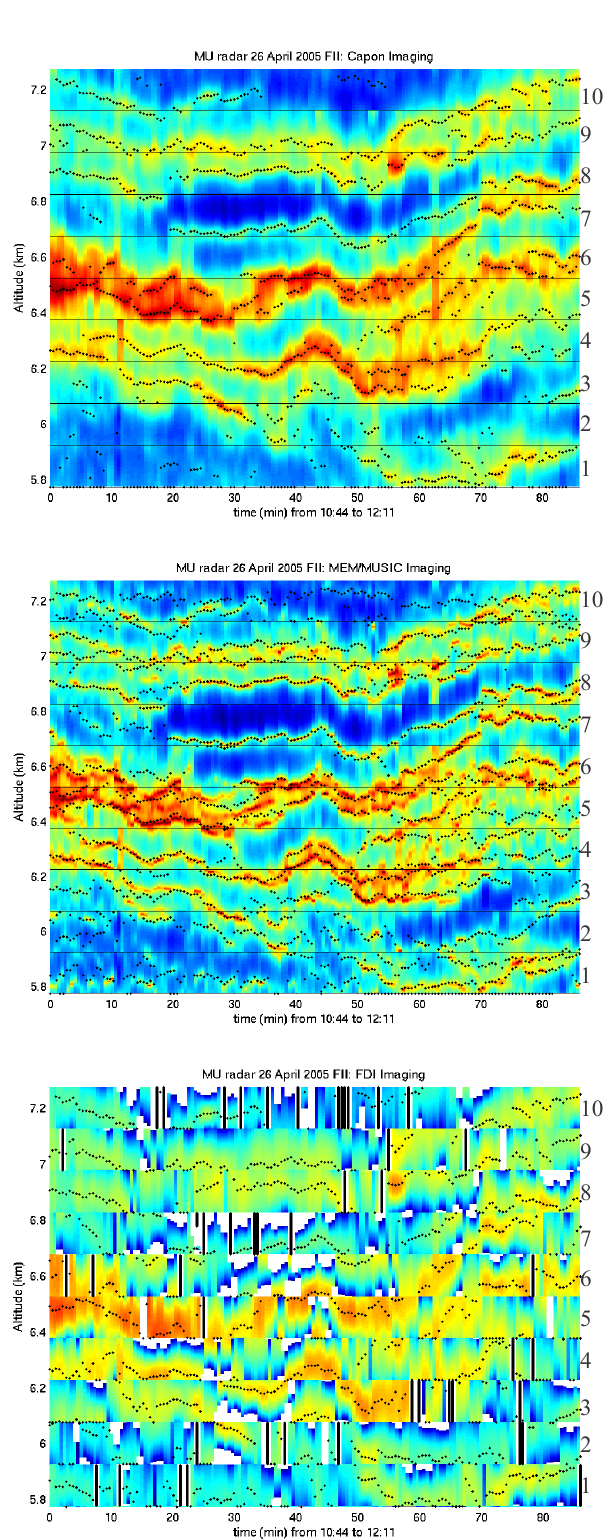
Fig. 5. Close-up of high-resolution patterns in the troposphere obtained from (a) the Capon method, (b) MEM, while dots indicate the positions of the peaks obtained with the MUSIC algorithm, (c) the